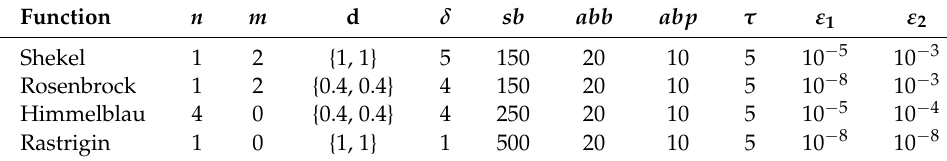
Table 8. MBC algorithm